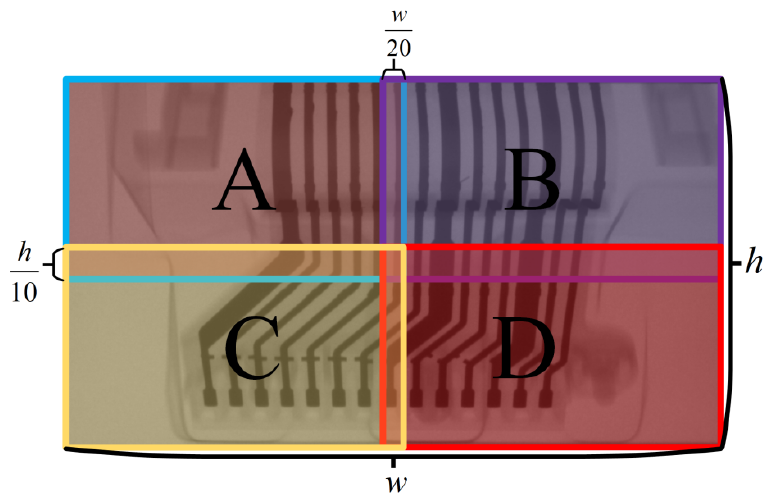
Figure 4. The DR images were cut by overlap. Where A, B, C and D represent the image blocks after the “image overlap” cut.